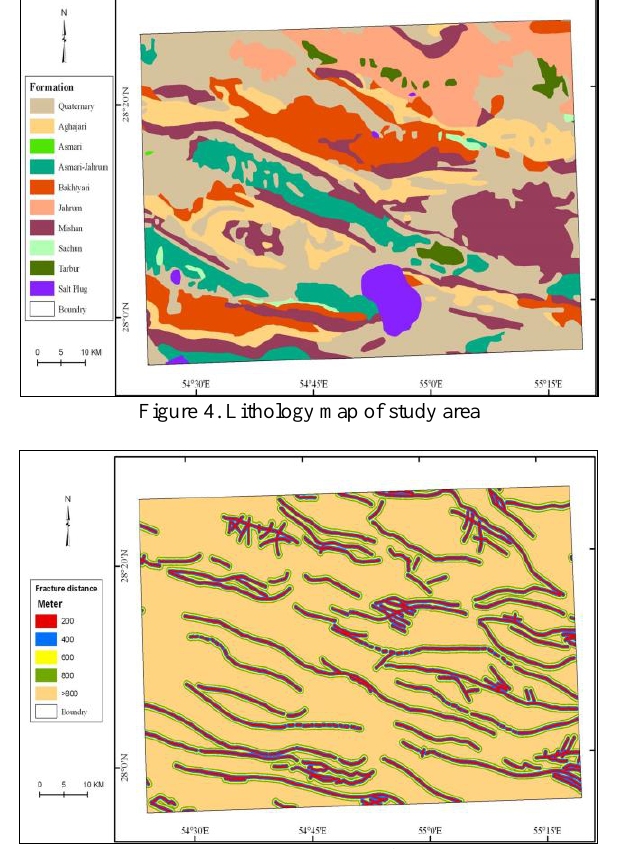
Figure 5. Fracture distance of study area